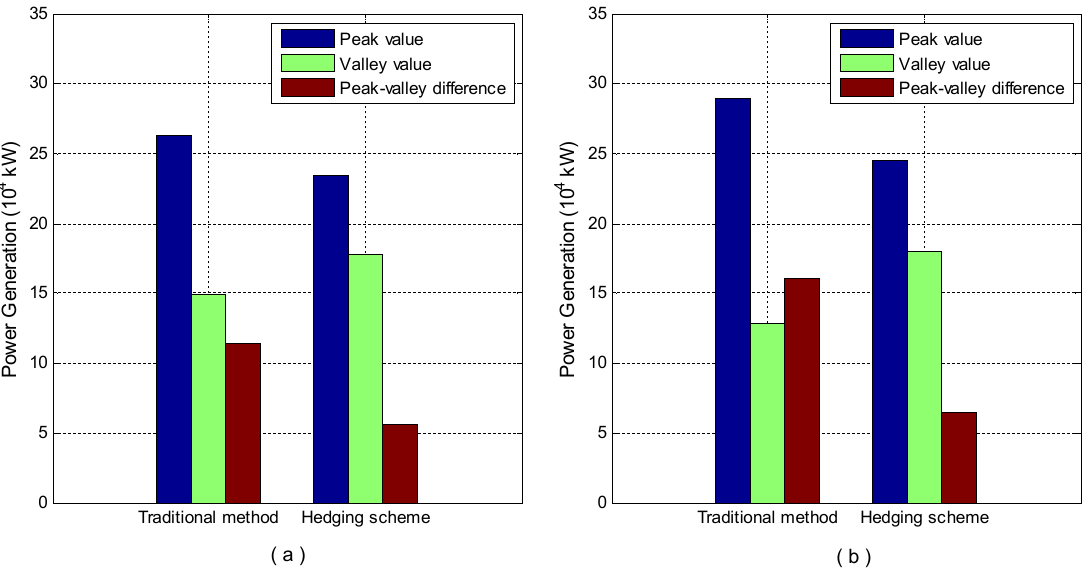
Figure 14. The comparison of hydropower and photovoltaic joint output’s volatility under the two schemes. ( a ) Comparison of peak valley difference between the traditional methods and hedging strategies in typical sunny day scenarios ( b ) Comparison of peak valley difference between the traditional methods and hedging strategies in typical cloudy day